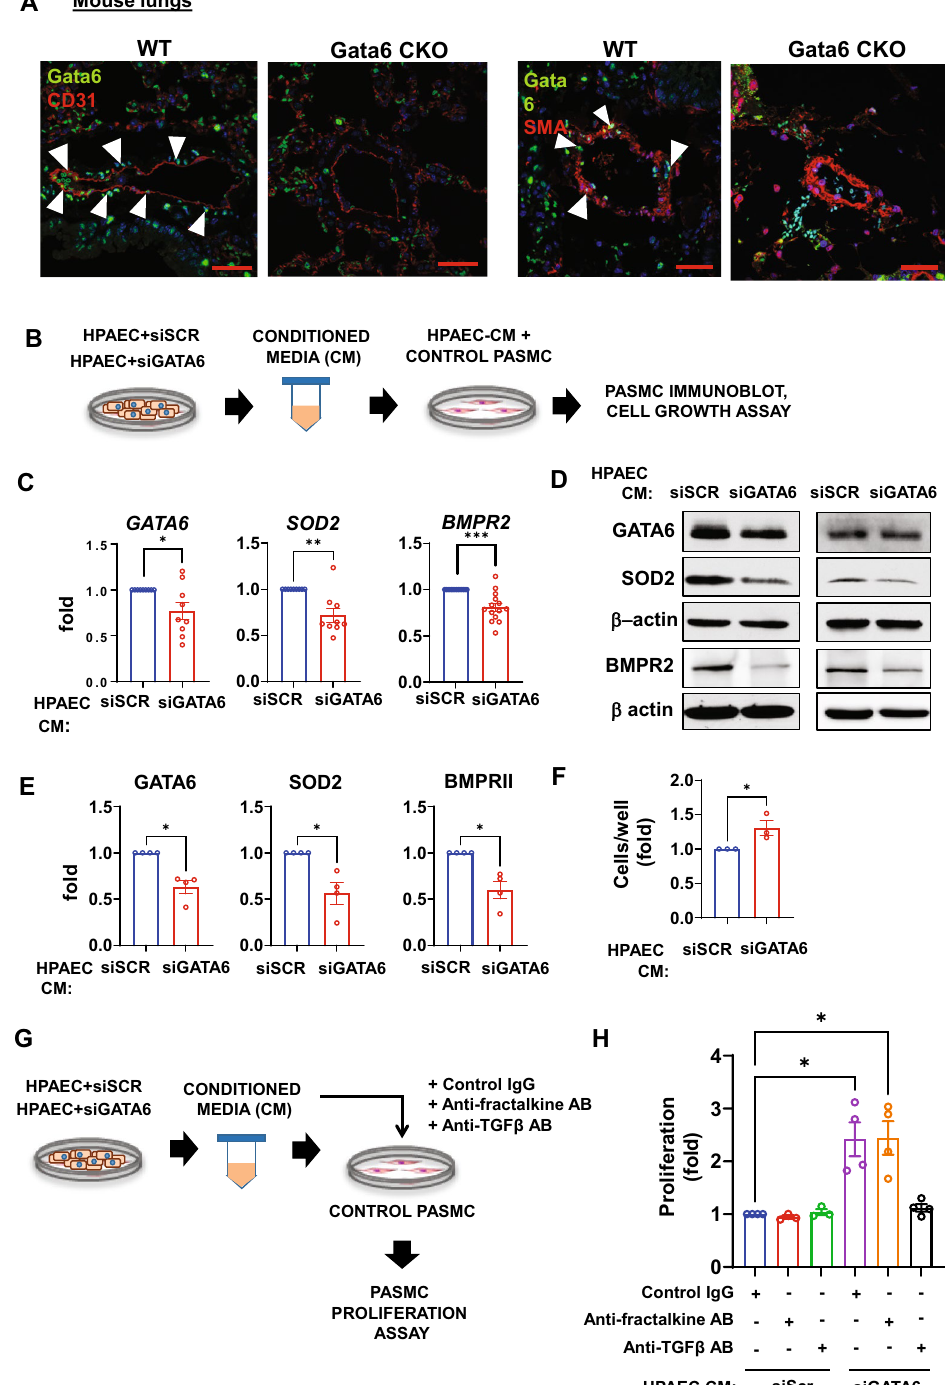
Figure 6. Endothelial GATA6 loss promotes GATA6 deficiency and increases growth of PASMC. ( A ) IHC stainings were performed to detect Gata6, CD31 and α-SMA in WT and Gata6 CKO mice; images are representative from 3 mice/group. Bar = 50 μm. White arrowheads indicate Gata6-positive cells. ( B ) Schematic representation of experiments ( C–F ). Media conditioned for 72 h by non-diseased human PAEC (HPAEC) transfected with GATA6 siRNAs or control scr siRNA was added to non-diseased distal human PASMC. ( C,D,E ) mRNA ( C ) and immunoblot analyses ( D,E ) of PASMC after 72 h incubation with HPAEC-conditioned media (CM) were performed. Data are means ± SE from n ≥ 3 repetitions. *p < 0.05, **p < 0.01, ***p < 0.001 by Mann Whitney U test. ( F ) Cell growth (cell counts) assay of PASMC after 48 h incubation with indicated HPAEC conditioned media (CM). Data are means ± SE, n = 3. *p < 0.05 by Mann Whitney U test. ( G,H ) PASMC were incubated for 48 h with indicated HPAEC conditioned media (CM) in the presence of 10 nM control IgG, anti- fractalkine antibody (AB), or anti-TGFβ AB. Schematic representation of experiment ( G ) and cell proliferation analysis ( H ) are shown. Data are means ± SE, n = 3–4/group. *p < 0.05 by Kruskal–Wallis test with post hoc Dunn’s test for multiple comparisons. The original blots are presented in Supplementary Fig.